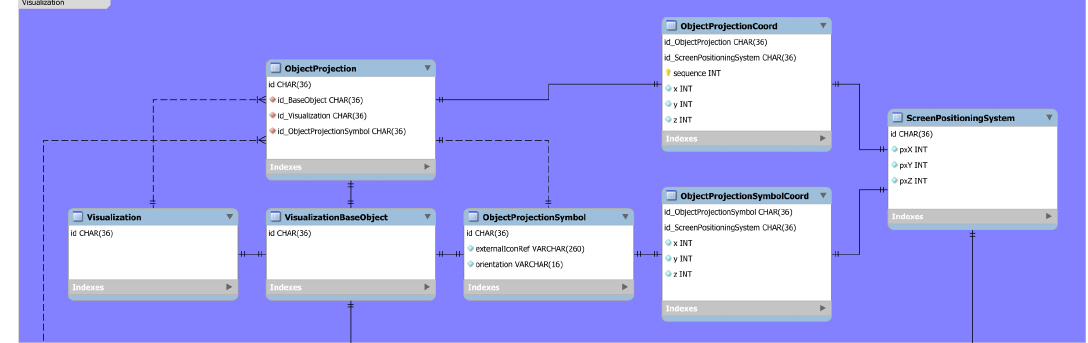
Figure 4. The visualization module of the Multipurpose Railway Infrastructure